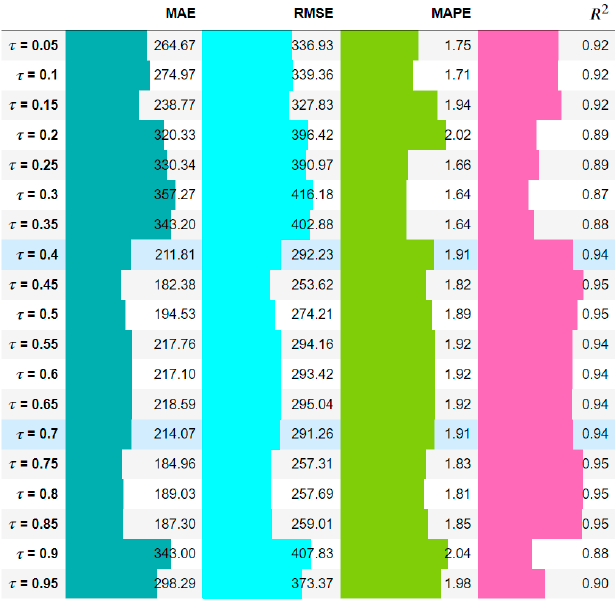
Figure 7. The graphed prediction results for various levels of 𝜏 .